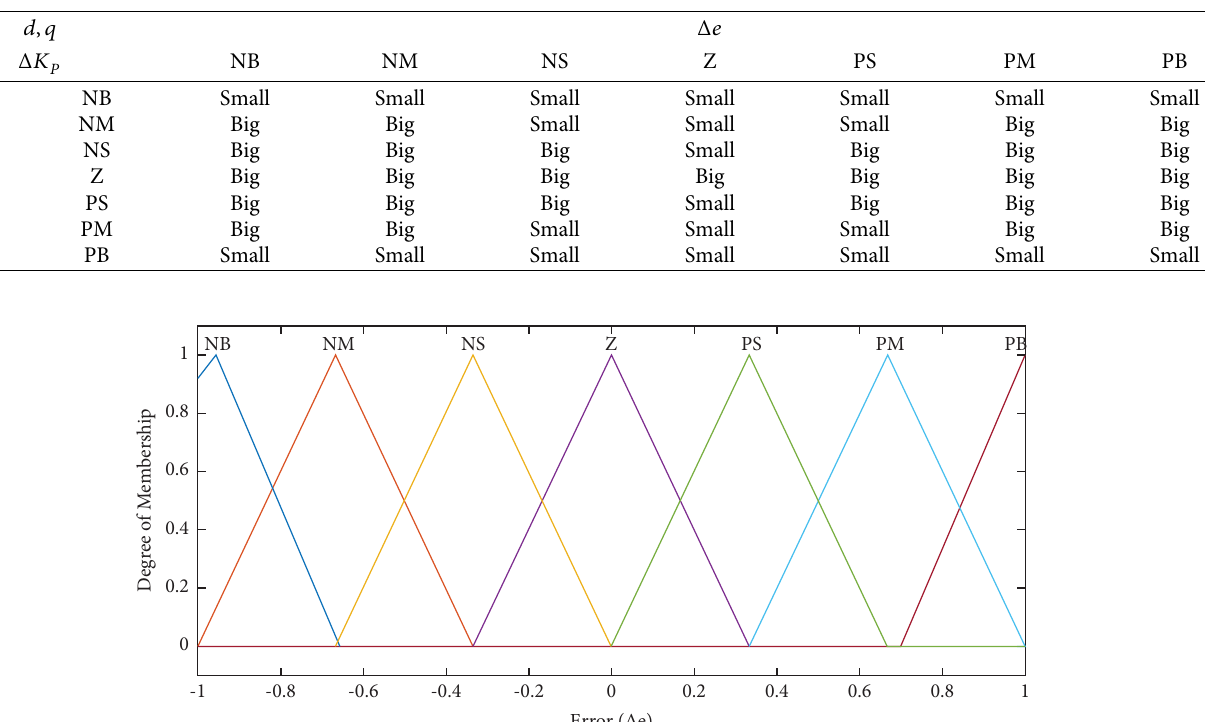
dq -axis. D output for